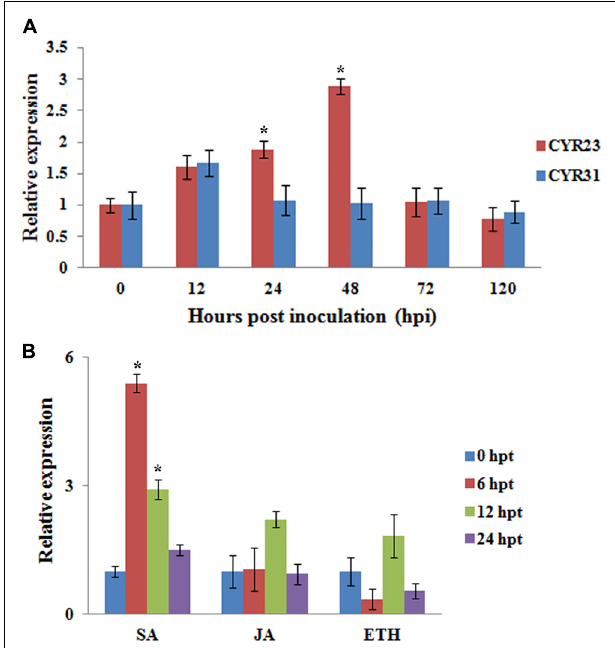
FIGURE 3 | qRT-PCR analysis of relative transcript levels of TaMAPK4 . (A) Transcript profiles of TaMAPK4 in wheat leaves (Su11) inoculated with Pst races CYR31 (virulent) and CYR23 (avirulent), respectively. (B) TaMAPK4 transcript profiles in wheat leaves treated with hormone elicitors. SA, salicylic acid; MeJA, methyl jasmonate; ET, ethylene. Mean expression values were calculated from three independent replicates. Significant differences were determined using Student’s t -test: ∗ P <